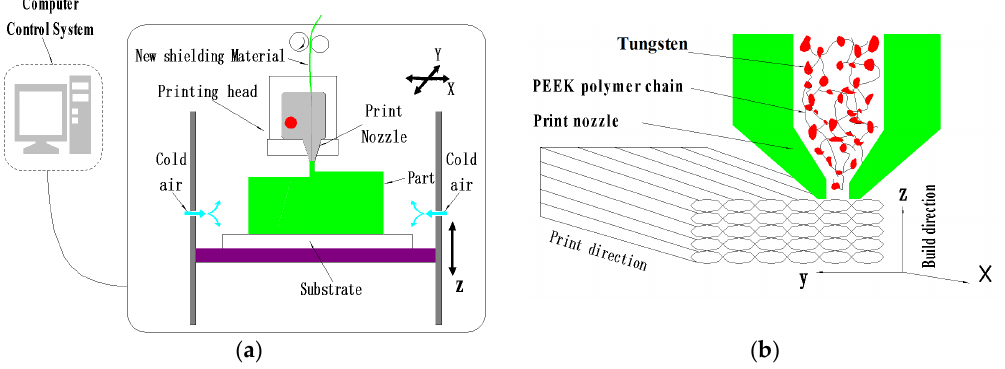
Figure 5. The mechanism framework and working principles of FDM: ( a ) FDM structure framework and ( b ) FDM printing and processing.